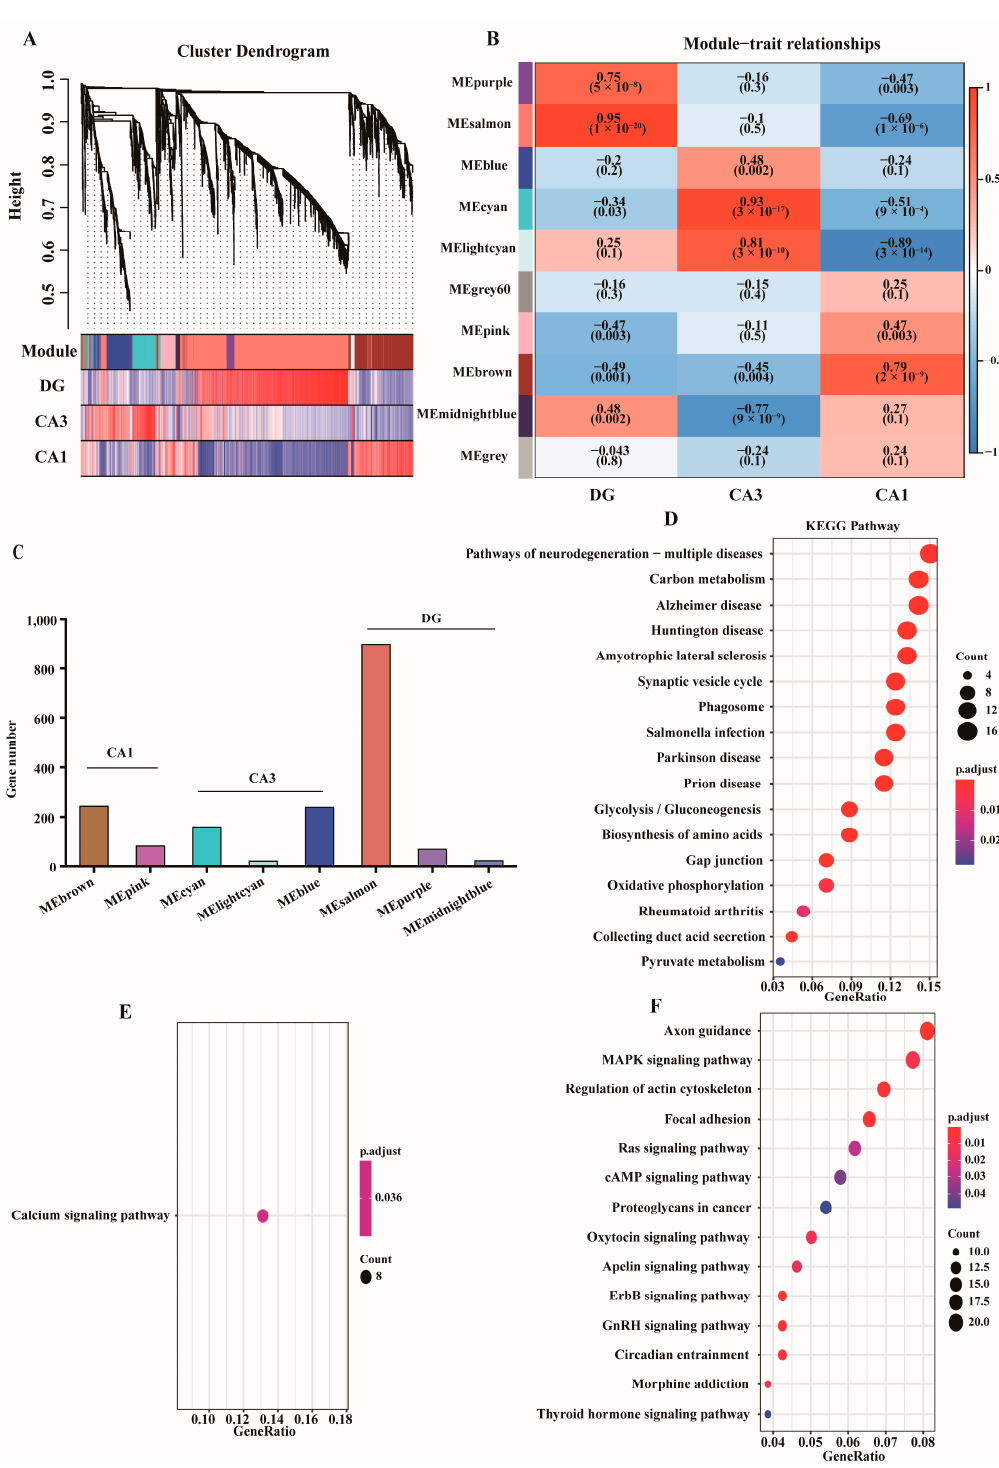
Figure 5. Construction of the co ‐ expression network. ( A ) Clustering dendrogram of all single ‐ cell samples. ( B ) Heatmap of the correlation between the module eigengenes and three subregions of PD. ( C ) The number of genes detected by different modules. ( D ) KEGG pathway analysis of brown module. ( E ) KEGG pathway analysis of cyan module. ( F ) KEGG pathway analysis of salmon module.